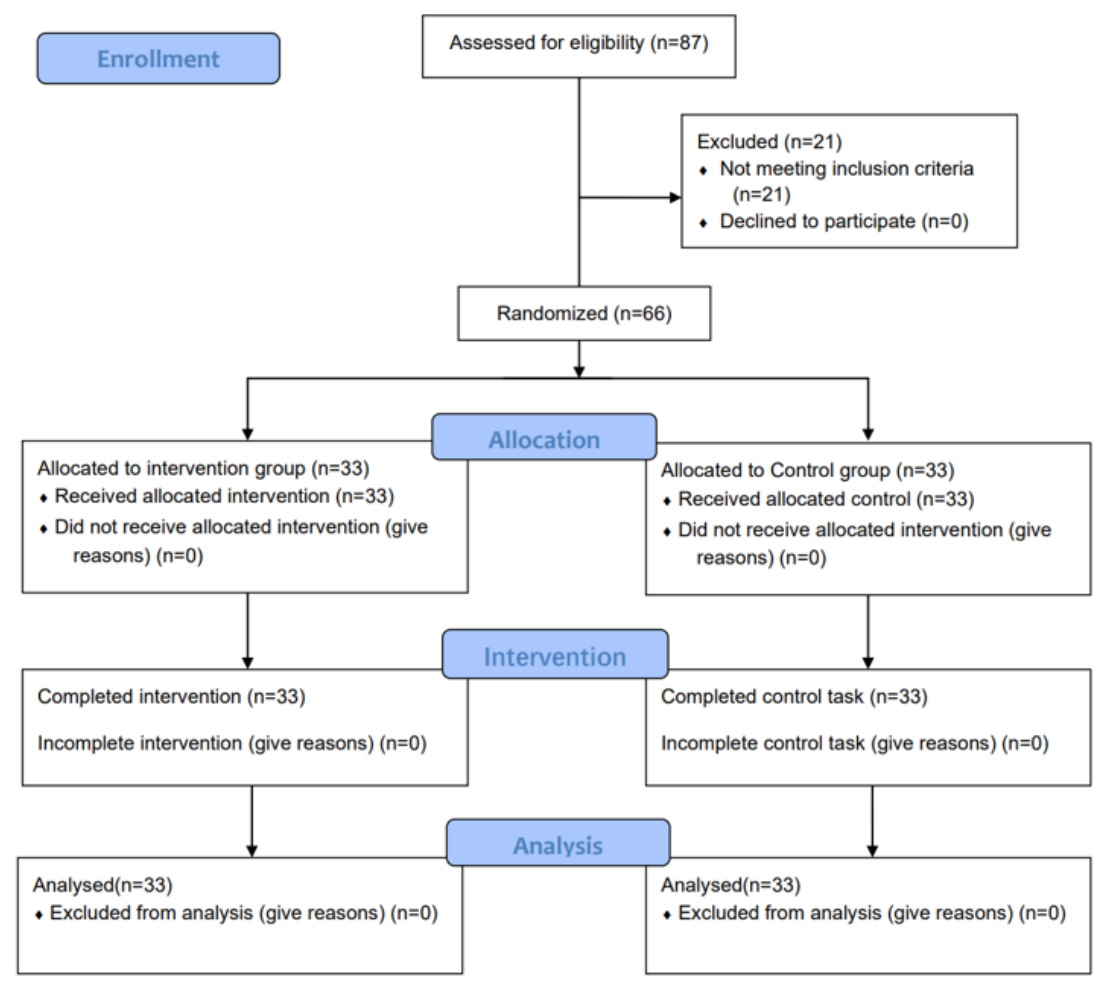
Figure 4. The CONSORT flow chart shows the acute percussive massage trial participant pathway. Intervention group = PT group.